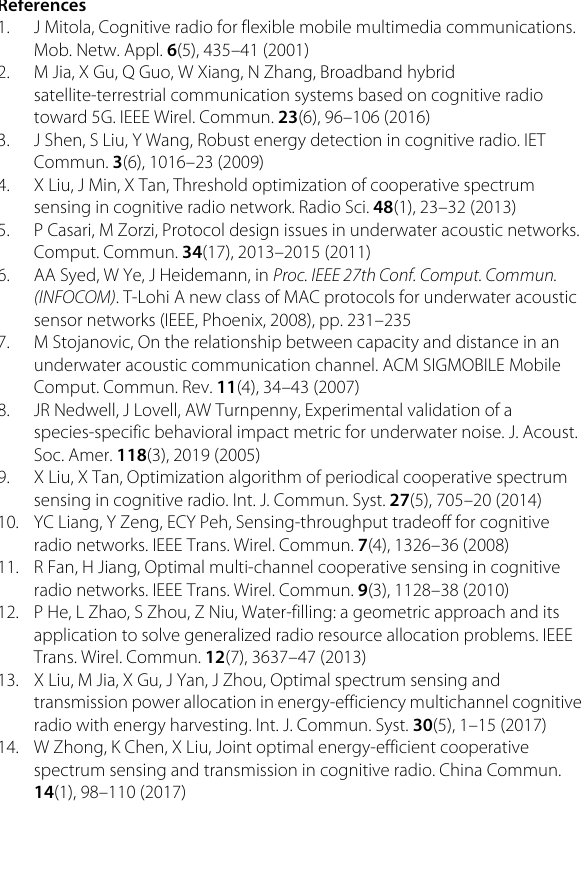
Fig. 7 Power utilization ratio comparison with maximal power